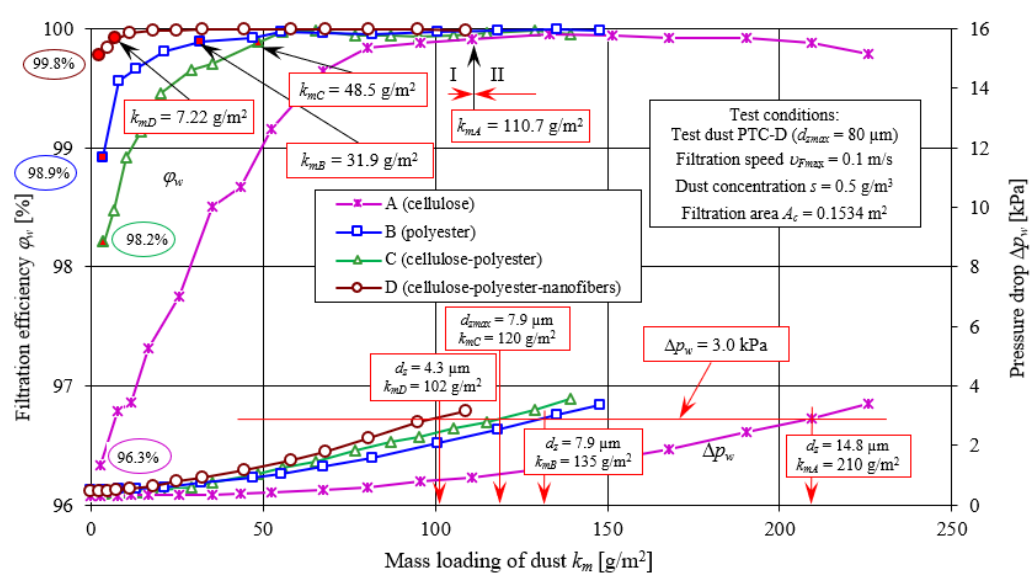
Fig. 13. Performance φ w and pressure drop ∆p w characteristics depending on dust absorption coefficient k m of tested filter cartridges A, B, C,